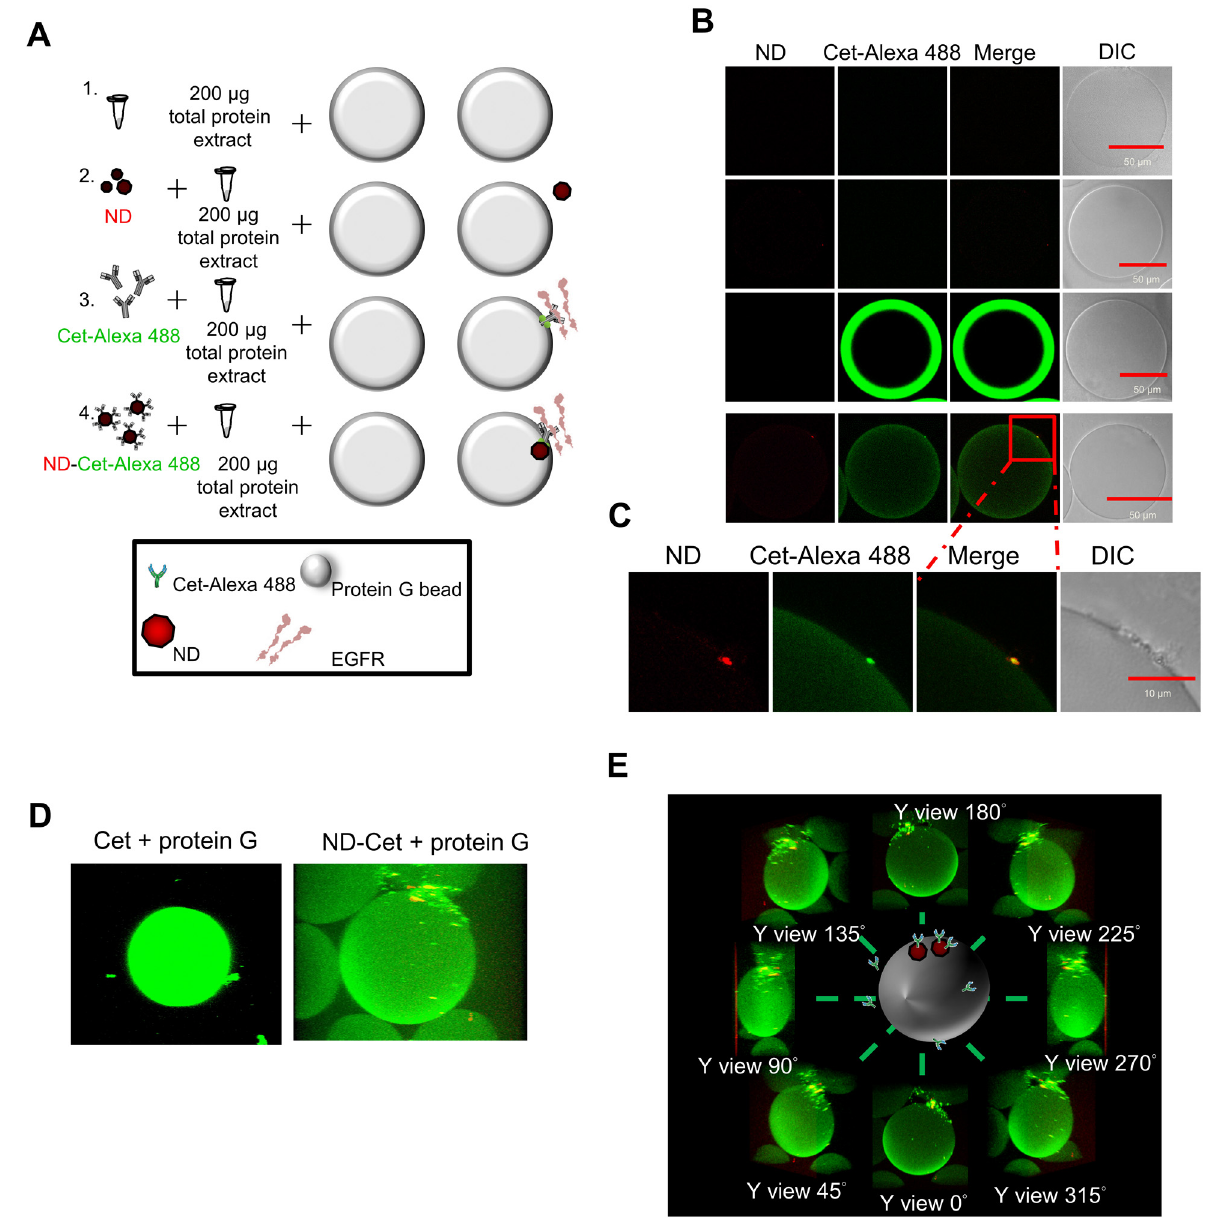
Figure 6. Observation of ND-Cet on a protein G-Sepharose bead binding with EGFR by confocal microscopy. ( A , B ) Cet was labeled with a fluorescence dye Alexa 488. The protein G-Sepharose beads were placed on the slide glass and observed under confocal after immunoprecipitation. The green fluorescence of Cet was excited with 496 nm and the emission was collected in the range of 515~520 nm. The red fluorescence of ND was excited with 580 nm, and the emission was collected in the range of 600~700 nm. Representative confocal image data were shown from one of three separate experiments with similar findings. ( C ) The marked red square indicating the edge of protein G bead was amplified. ( D ) Three-dimensional (3D) images show ND-Cet binding with EGFR proteins on protein G-Sepharose beads. The green fluorescence of Cet was excited with 496 nm and the emission was collected in the range of 515~520 nm. The red fluorescence of ND was excited with 580 nm and the emission was collected in the range of 600~700 nm. A protein G bead was from a series of individual Z-slices taken by confocal microscopy. Representative confocal image data were shown from one of three separate experiments with similar findings. ( E ) Different angles-axis rotation of ND-Cet-binding EGFR proteins on a protein G bead.